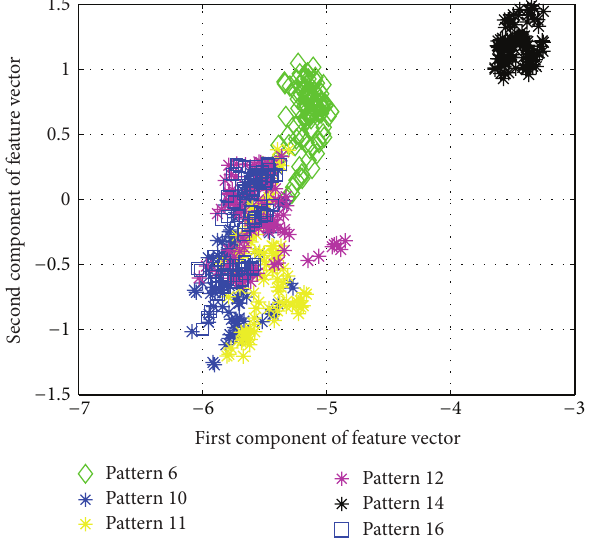
Figure 7: The AR feature vectors of data patterns in second scenario from sensor node 232 using Mahalanobis distance.